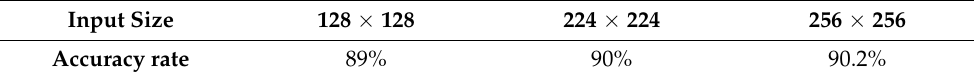
Table 4. The input size comparison.